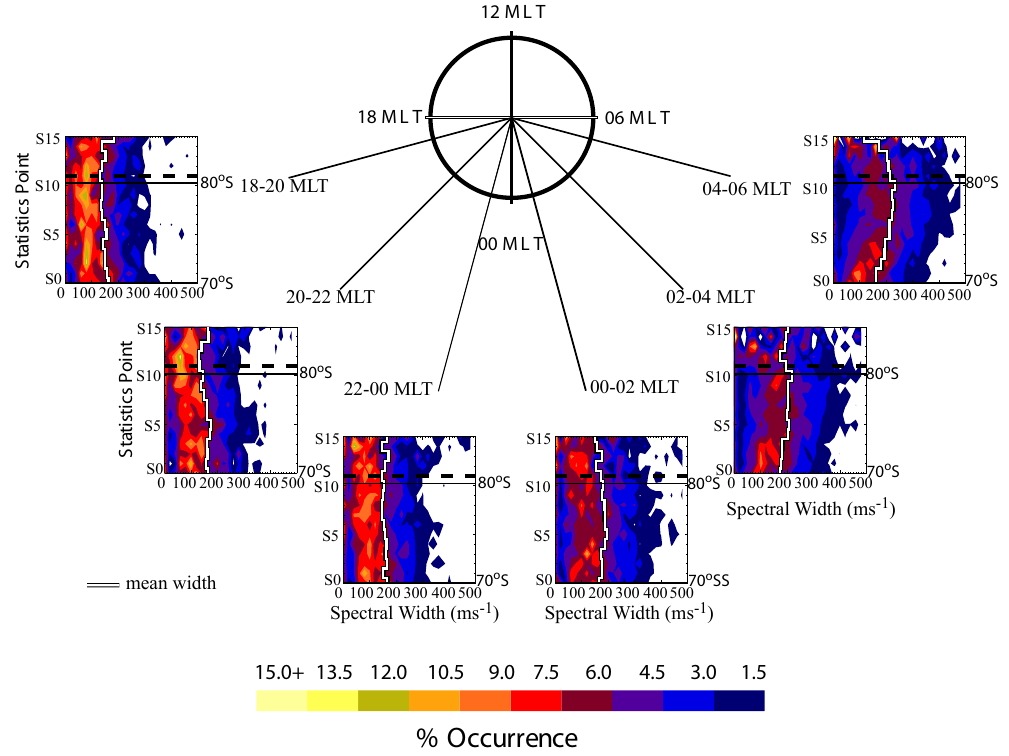
Fig. 6. Contour plots showing the Southern Hemisphere winter variation of spectral width distributions with MLT from Syowa East. The points above the black dashed line do not overlap with the Iceland East points. The 70 ◦ S and 80 ◦ S positions are indicated by the thin black lines. The white on black lines show the mean spectral width value for each point on the lower axis scale. The colour scale indicates the occurrence at each width normalised to the total occurrence for each summary